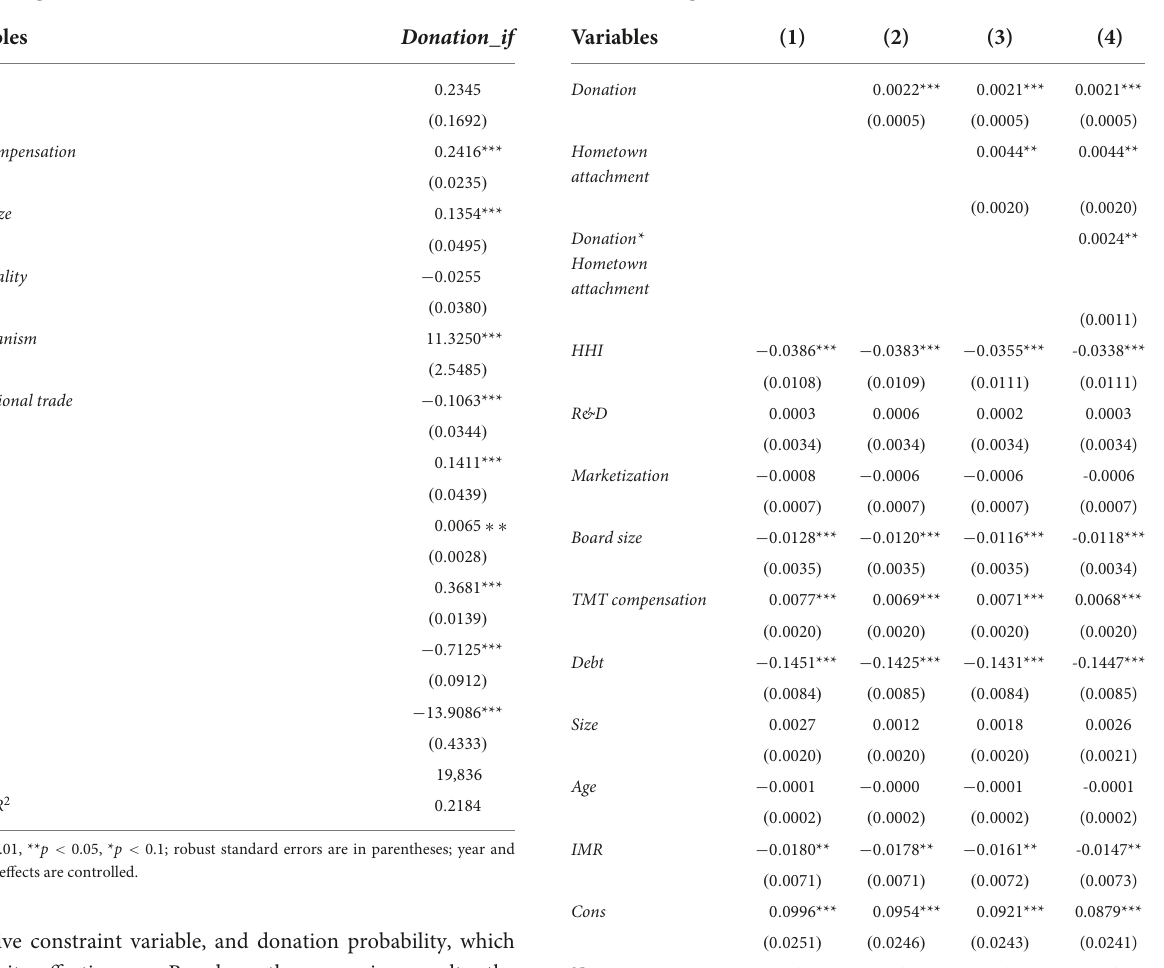
TABLE 6 Relationship between donation and firm performance and the moderating effect of hometown